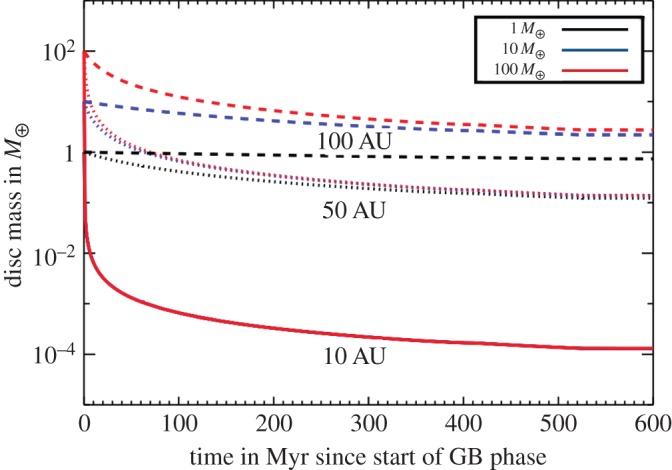
Cosmetically enhanced version of the lowest panel of fig. 4 of [32]. How GB evolution of a M⋆(MS)=2.9 M⊙ star depletes a debris disc due to collisional evolution alone. The legend indicates the initial disc masses. The solid lines correspond to {r=10 AU,rd(min)=7.5 AU, rd(max)=12.5 AU}, the dotted lines correspond to {r=50 AU, rd(min)=37.5 AU, rd(max)=62.5 AU} and the dashed lines correspond to {r=100 AU, rd(min)=75 AU, rd(max)=125 AU}.